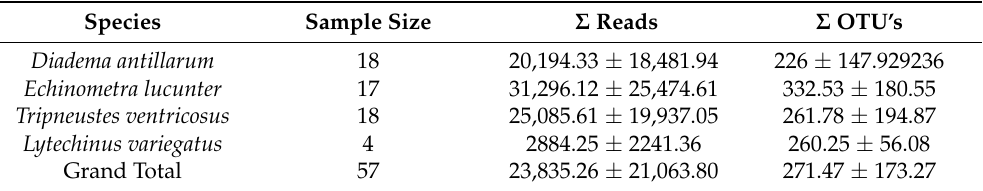
Table 2. Numbers of Operational Taxonomic Units and read sequences of four sea urchin species at three sites in Puerto